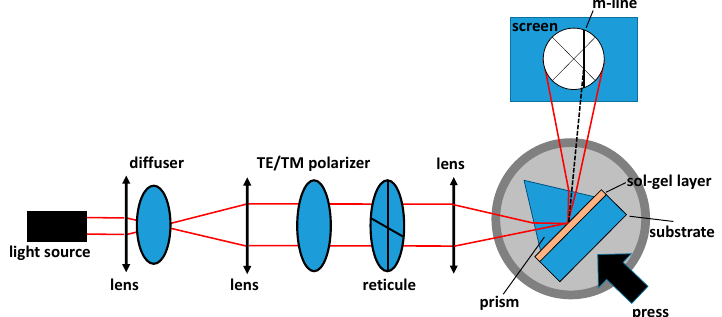
Figure 3. M-line spectroscopy used for the effective refractive index of the TiO 2 -SiO 2 sol–gel layers. A 633 nm light source is used.